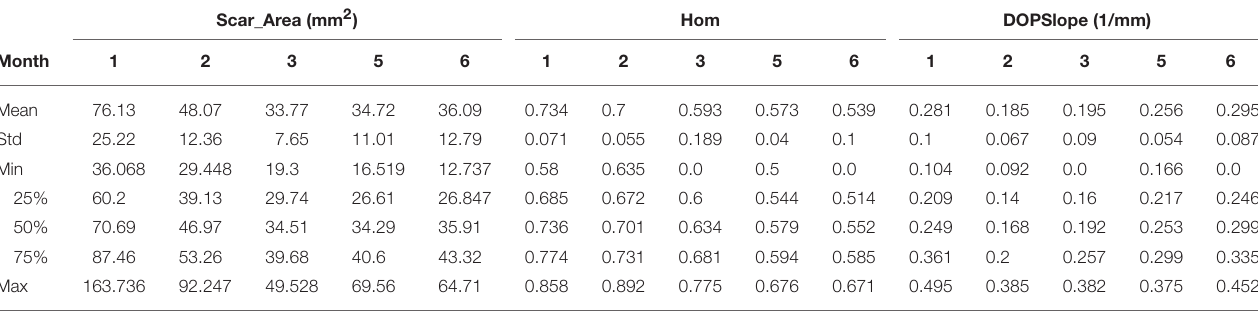
TABLE 1 | Measured parameters of third-degree burn scars in rats with/without pIRE treatment. Scar_Area (mm 2 )